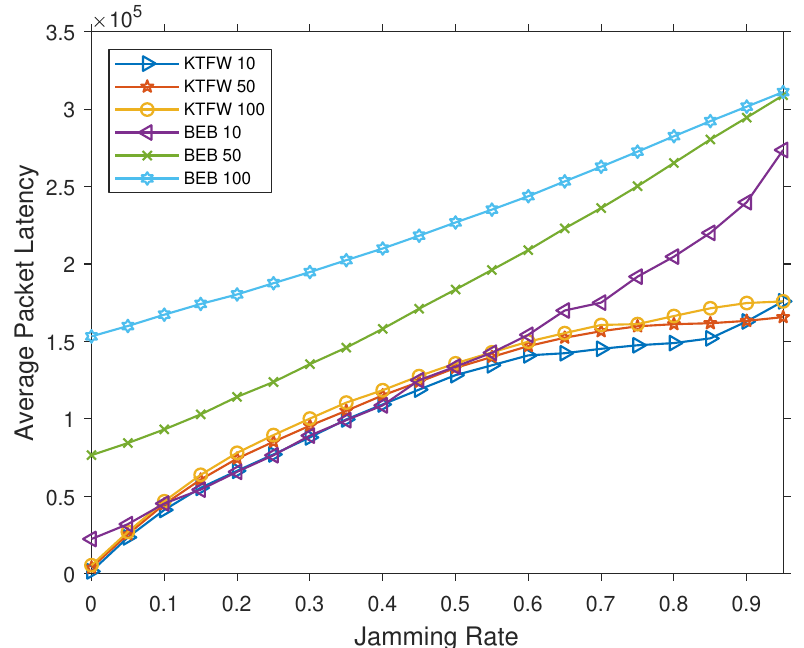
Figure 12. Comparing the average packet latency for the BEB and KTFW algorithms for all jamming rates and n ∈ [ 10,50,100 ]